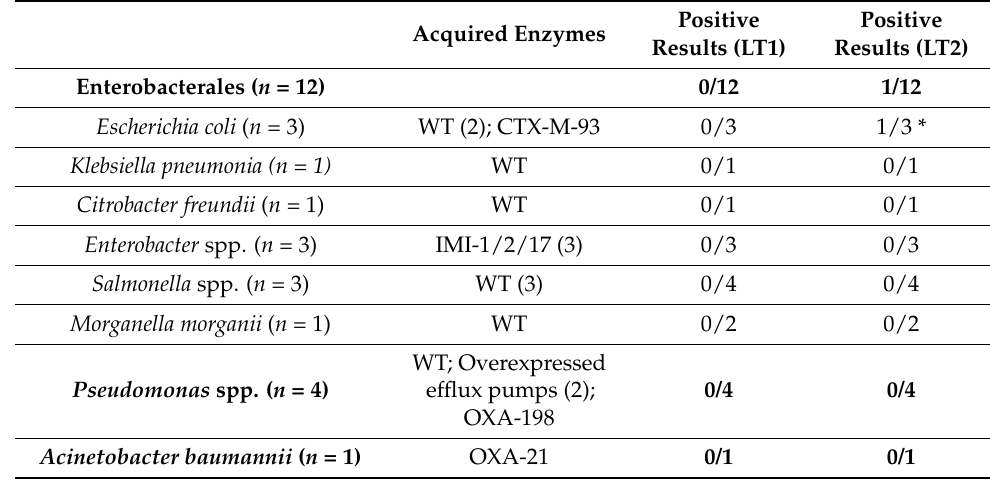
Table 1. LFIA Rapid ESC test results for the 17 isolates with no CTX hydrolyzing activity.